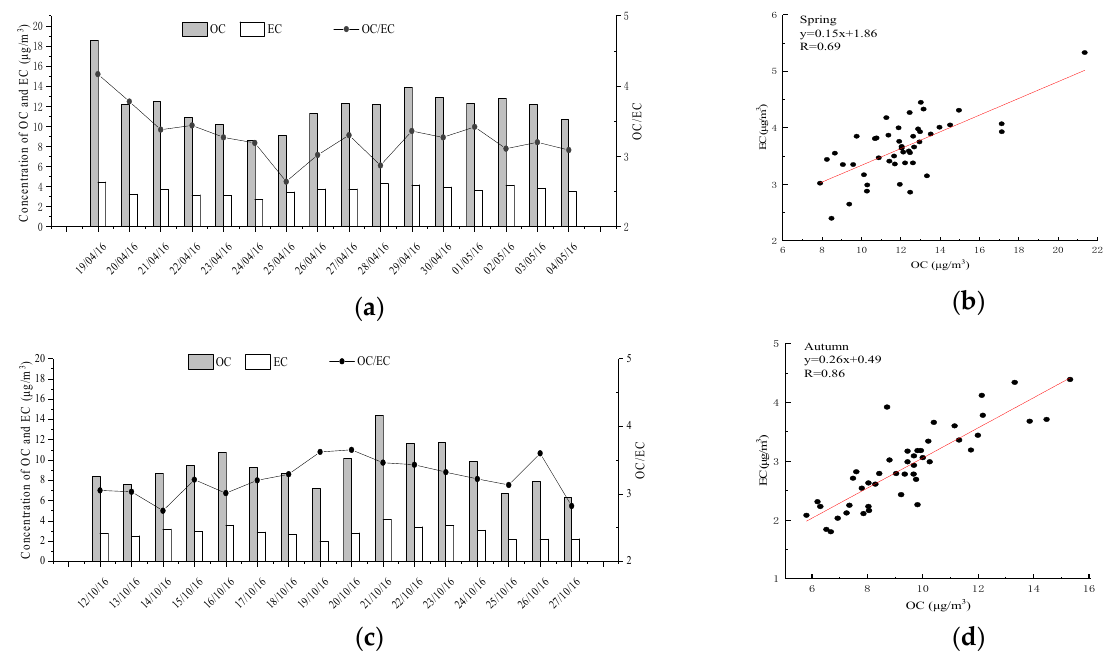
Figure 5. Concentrations of OC and EC, the value of OC/EC and the relevance of OC and EC in PM 2.5 during the sampling period. ( a ) Concentrations of OC and EC in spring. ( b ) Concentrations of OC and EC in autumn. ( c ) The value of OC/EC and the relevance of OC and EC in PM 2.5 during the spring sampling period. ( d ) The value of OC/EC and the relevance of OC and EC in PM 2.5 during the autumn sampling period.